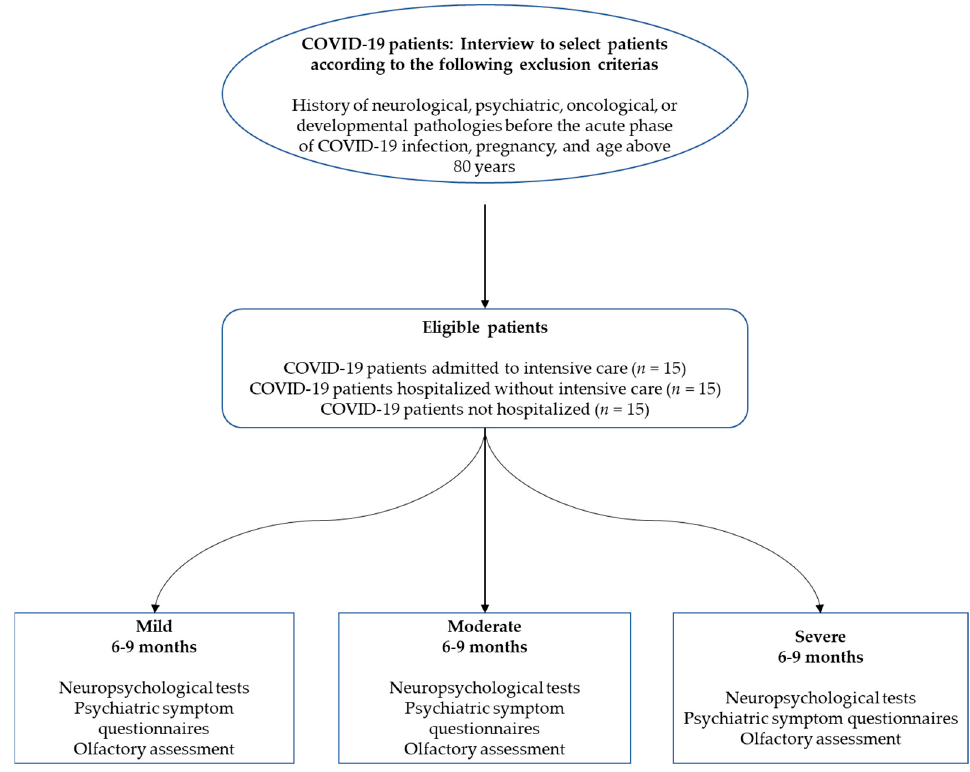
Figure 1. Flowchart of the study .